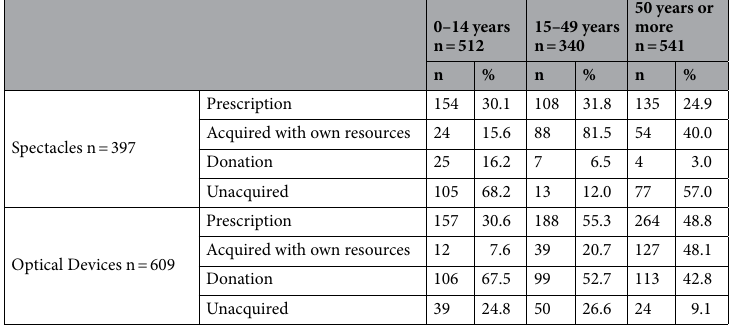
Table 4. Prescription and acquisition of spectacles and optical devices per age group (n = 1393). n number of